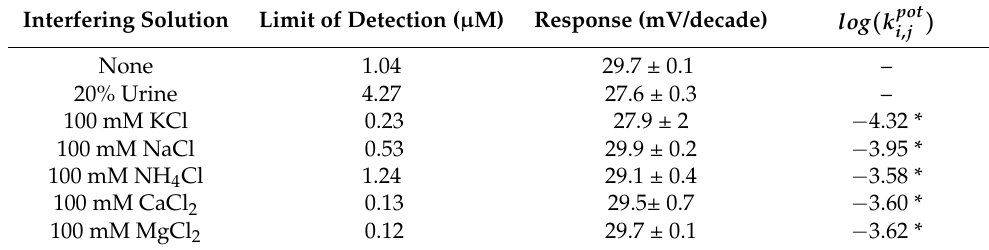
Table 2. The interference of ionic compounds on SUX detection using CX4-thread-based ISEs. Interfering